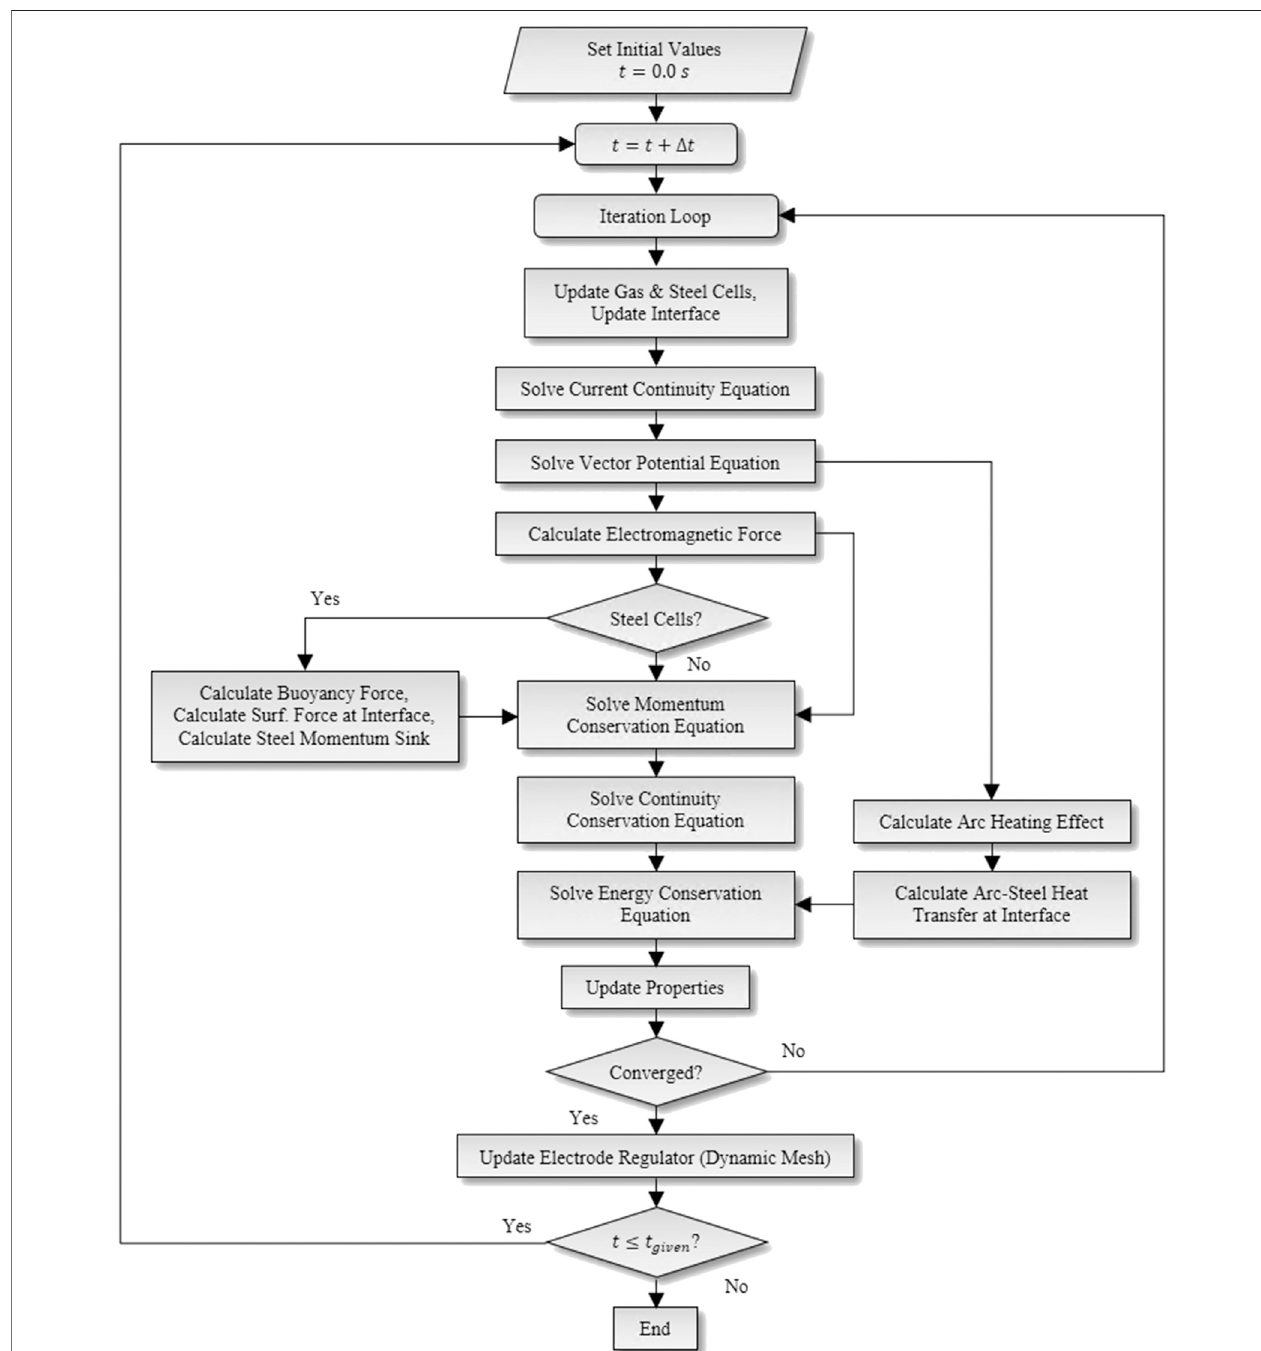
FIGURE 2 | Flow chart of the CFD